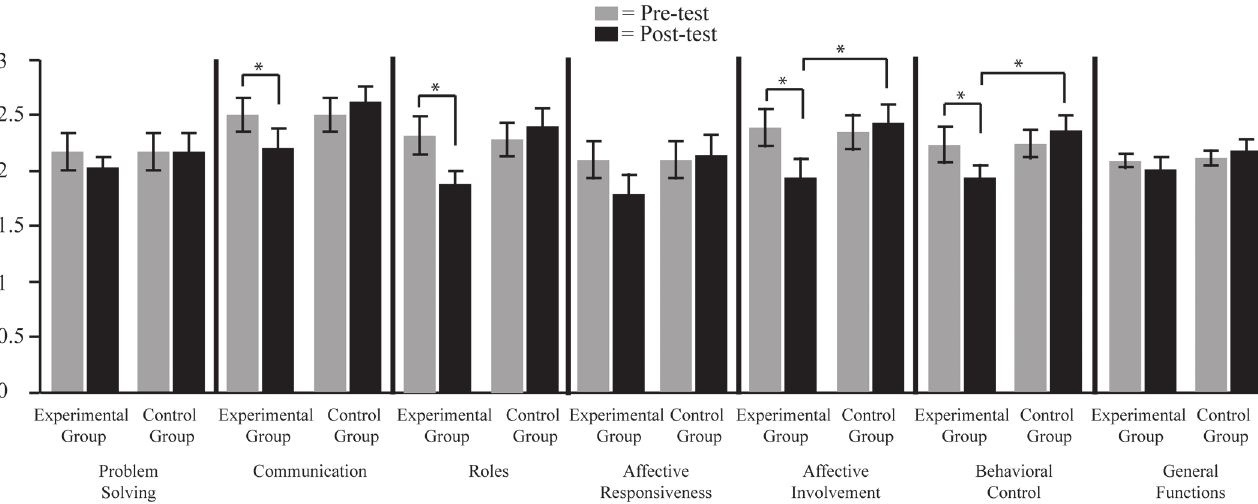
FIGURE 2. The average scores of the McMaster Family Assessment Device between experimental and control groups within pre- to post-tests among